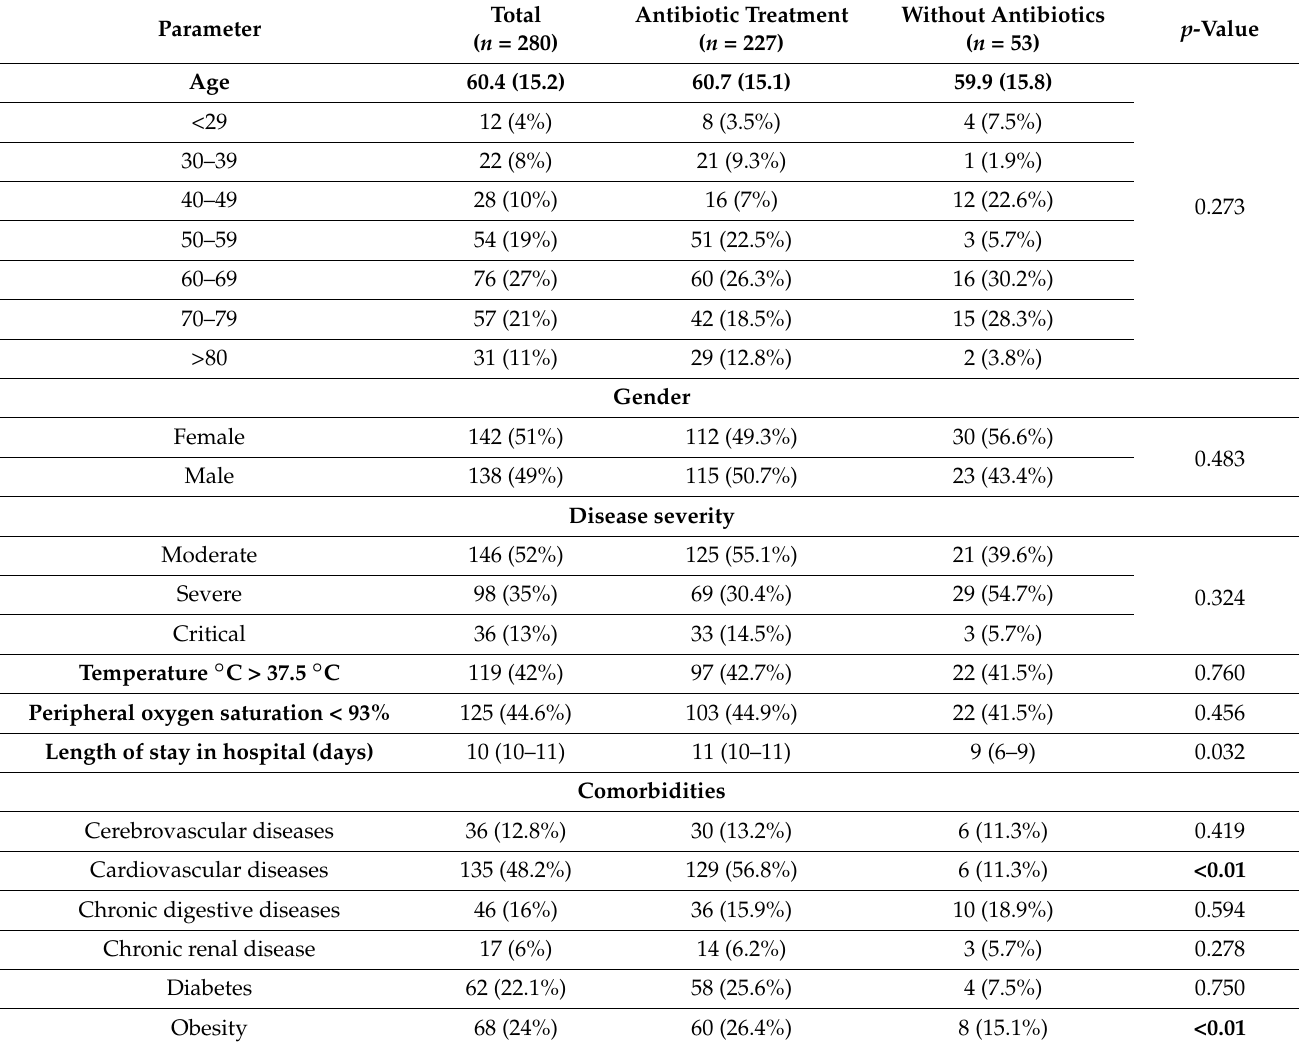
Table 1. Baseline characteristics and